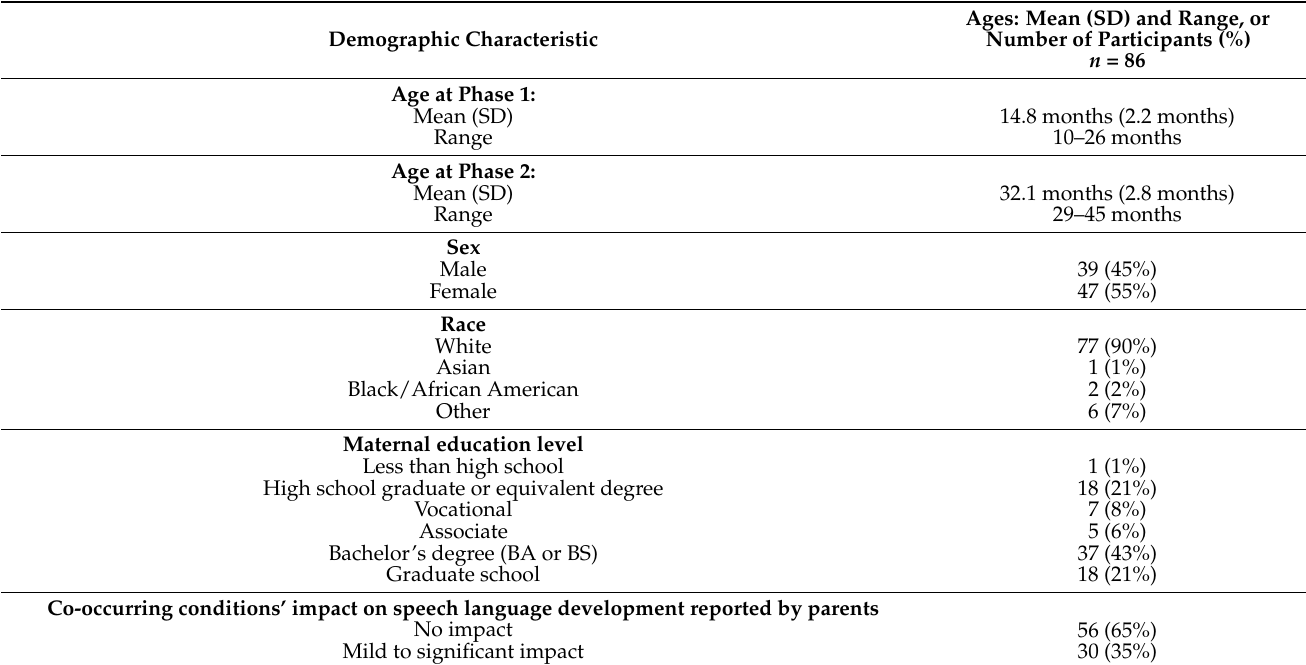
Table 1. Participant demographic characteristics.